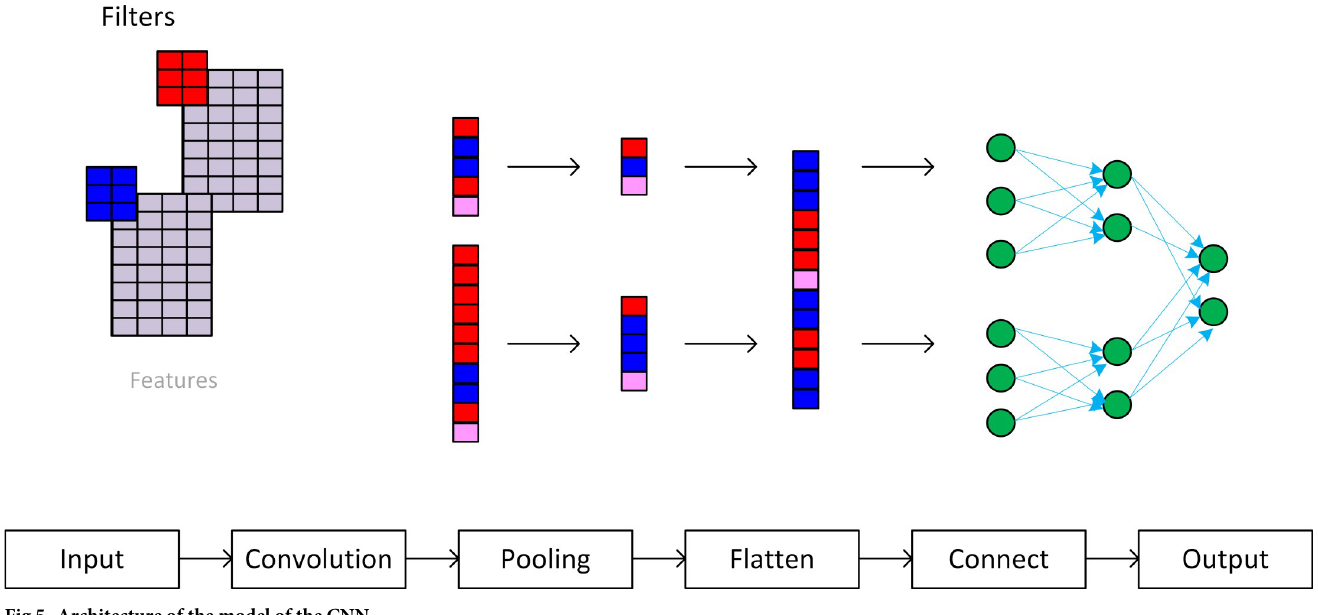
Fig 5. Architecture of the model of the CNN.